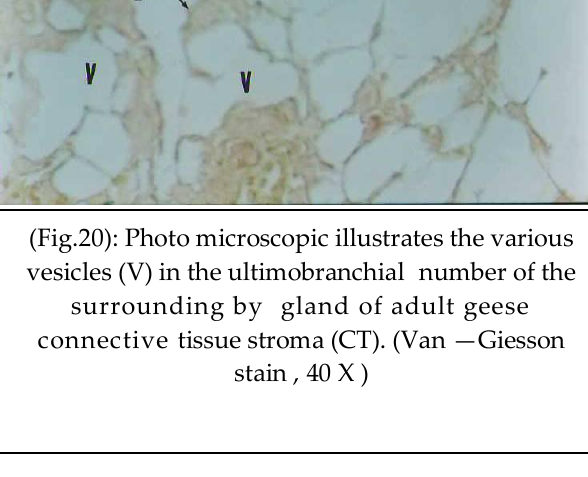
th at vesicles (V) of the ultimobranchial gland